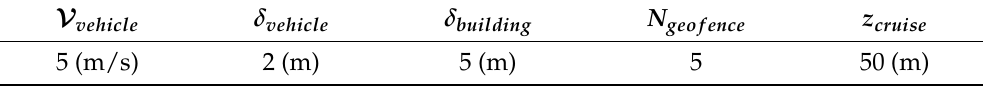
Figure 11. Flow chart of pathfinding logic for different start and end locations. In the chart, V.G. abbreviates visibility graph, and h bldg is the height of a geofence around a cluster of buildings. If the departure/destination is not inside the keep-out geofence ROI box, h bldg at start/end point is set to street/terrain altitude. Table 1. Control parameters for geofenced flight planning case studies.